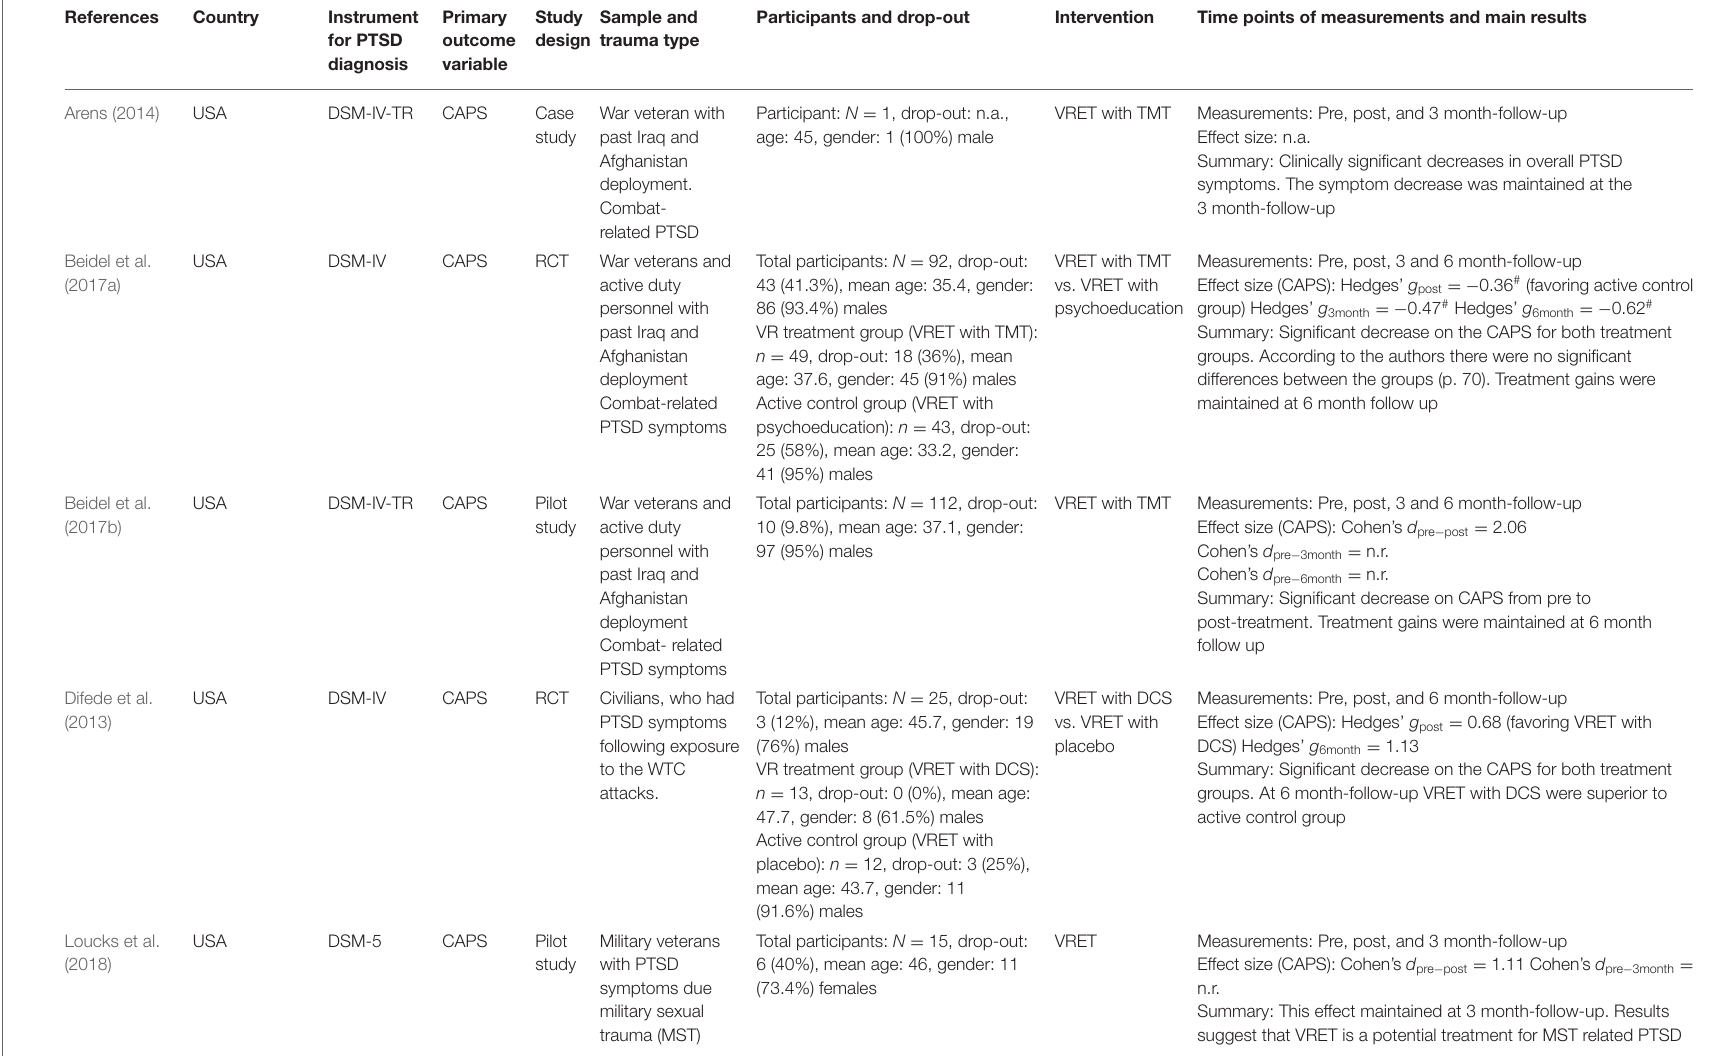
TABLE 1 | Descriptive characteristics of k = 18 included